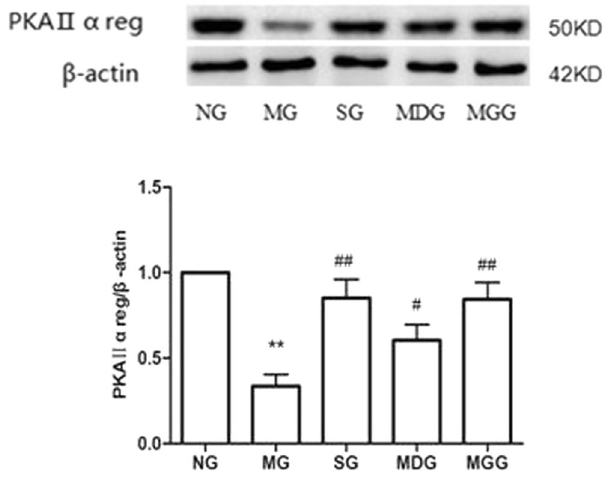
Figure 3. Effects of meloxicam on PKAII α reg protein expression in CUMS rat cortices. NG: normal group. MG: CUMS group. SG: Sertraline group. MDG: Meloxicam (1 mg.kg − 1 ) group. MGG: Meloxicam (3